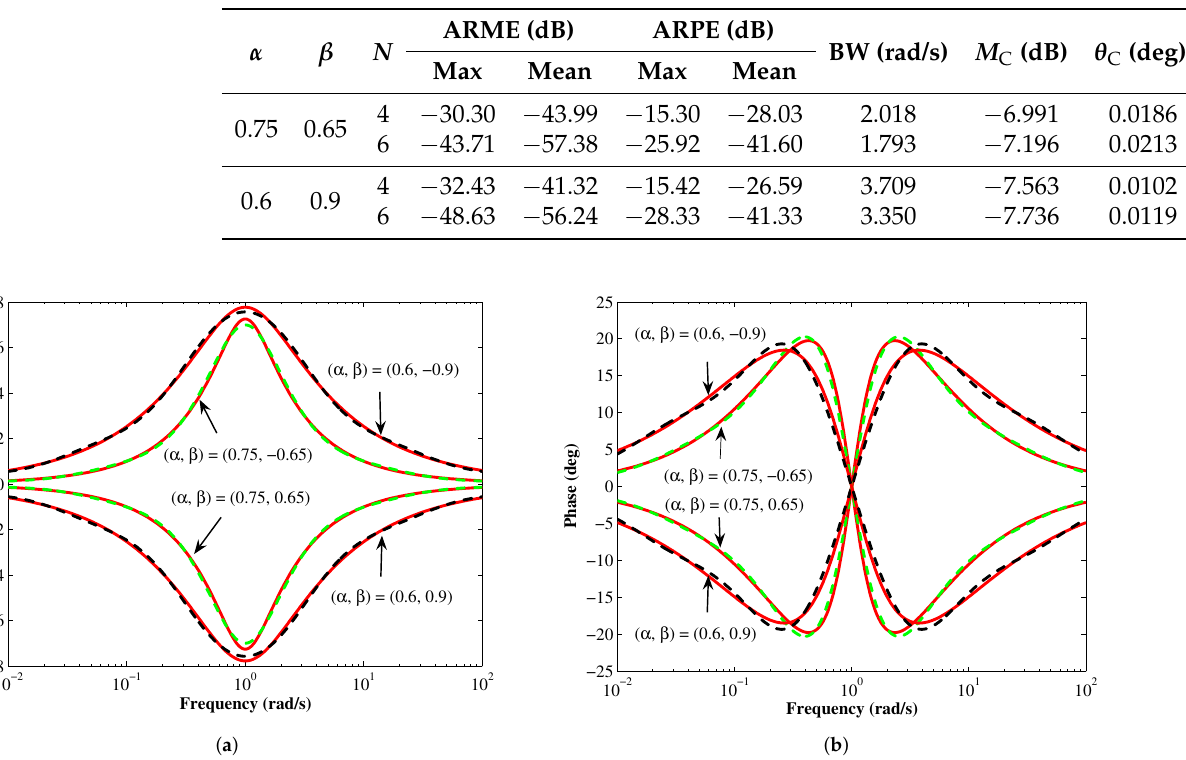
Figure 8. ( a ) Magnitude and ( b ) phase responses of the proposed FBSFs and FIBSFs for N = 4. The theoretical response is shown in solid